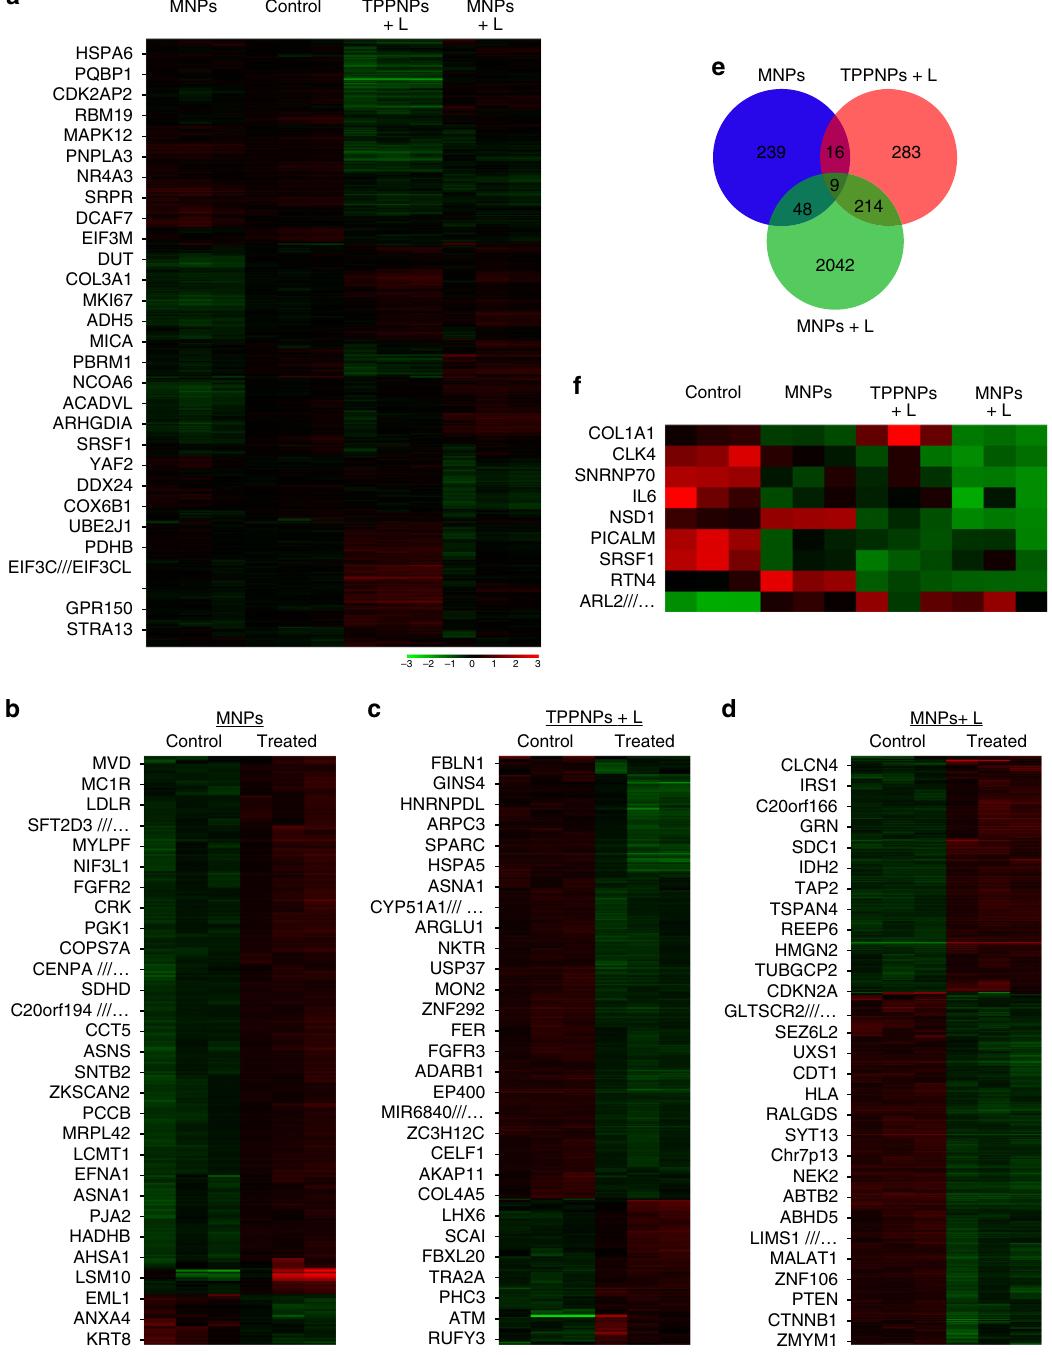
Fig. 6 Whole-gene expression analyses of tumors from the mice treated with different formulations. a Heat-map for GeneChip ® PrimeView ™ Human Gene Expression Array of mice treated with chemotherapy, PDT or photochemotherapy. Altered genetic pro fi le of tumors treated with b MNPs, c TPPNPs + L, or d MNPs + L compared with the untreated control group. e The venn diagram that displays the number of common characteristics among signi fi cantly altered genes from three different treatments. Arabic numerals represent the number of signi fi cantly altered genes. f Selection of potential gene targets involved in tumor regression in response to different for the different therapeutic groups were obtained by plotting the negative log of the p -value on the y -axis and the log2 fold change value on the x -axis. Highly deregulated genes (black dots) appeared further to the left and right sides, while highly sig- ni fi cant changes (color dots) appeared higher on the plot (Sup-